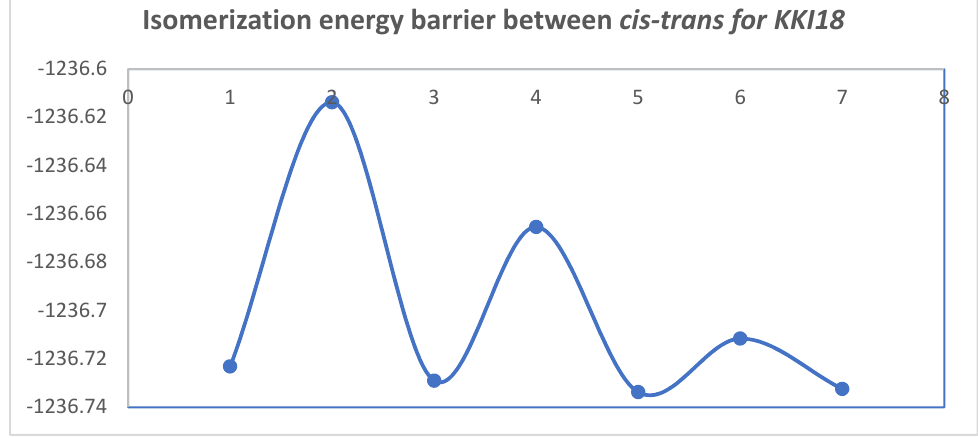
in Hartree, x = conformation).